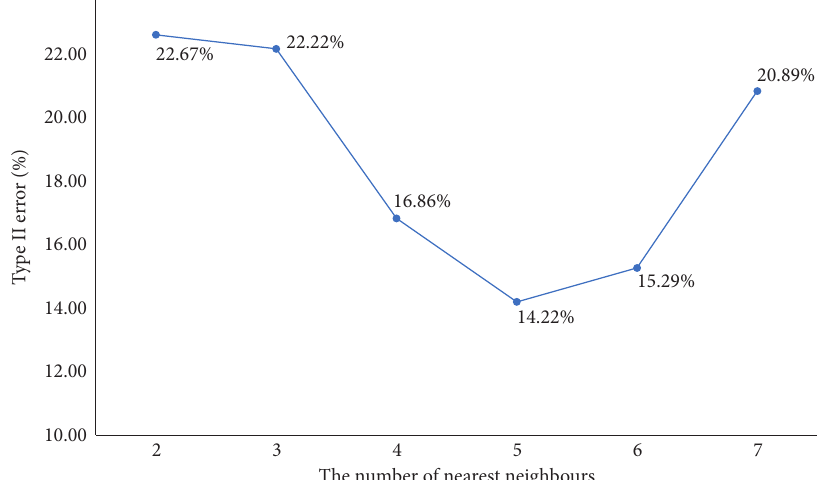
Figure 9: Variations of Type II error with the increased number of nearest neighbors for M-GL.